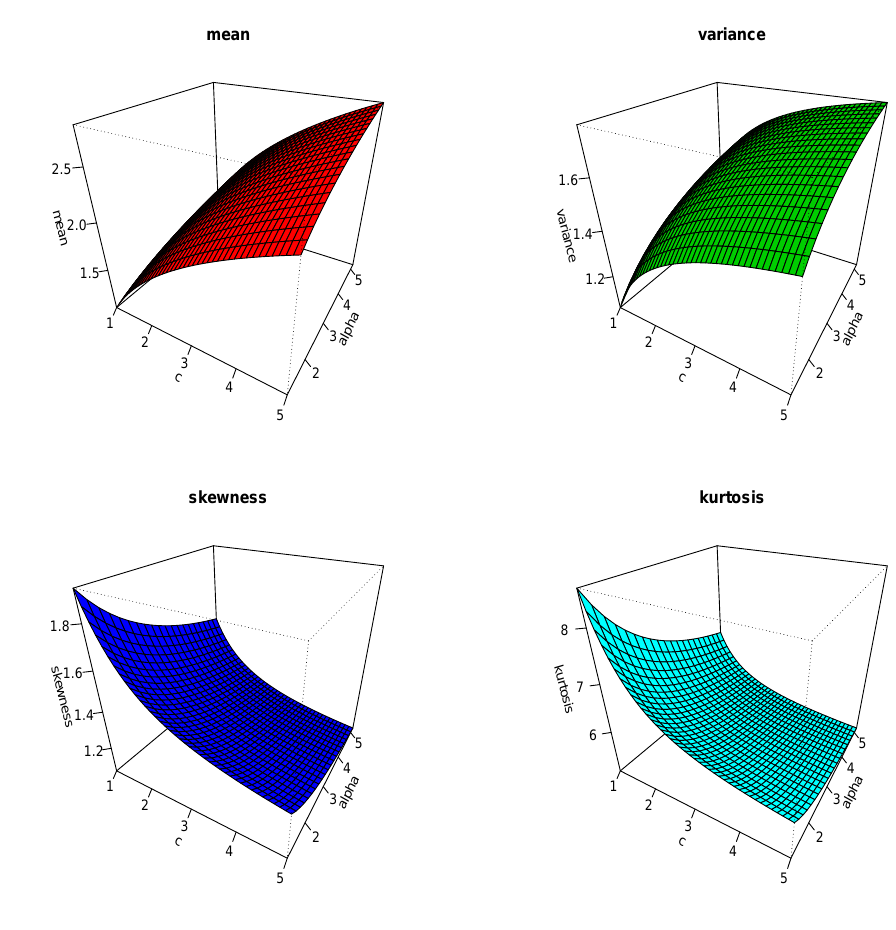
Figure 3. Plots of the mean, variance, skewness, and kurtosis of the APExE model with a =